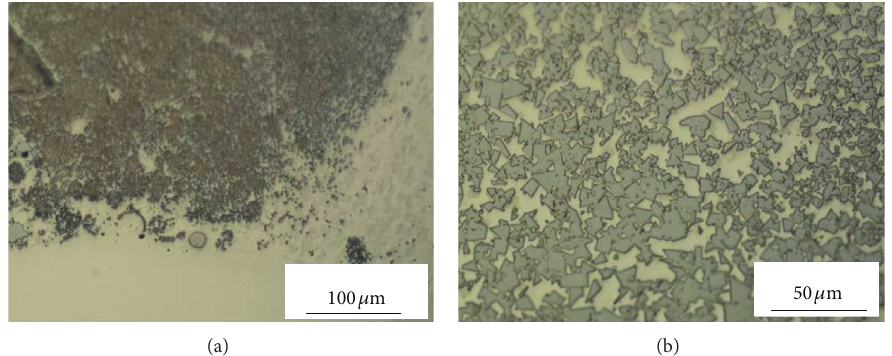
Figure 6: (a) Interface between the deposited material and the AISI 304 substrate (200x magnification); (b) microstructure of the deposited material (400x magnification).